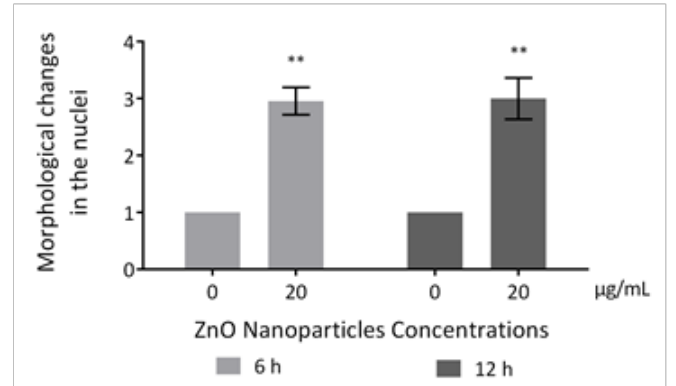
Figure 6. Influence of ZnO NPs in cytoskeleton structure and in nuclear morphology of GC-1 spg cells by immunocytochemistry: Immunocytochemistry images of ( A ) β -tubulin, ( B ) acetylated α -tubulin, and ( A , B ) F-actin; ( C ) relative fluorescence intensity quantification of α -tubulin, β -tubulin, and F-actin protein levels; and ( D ) morphological analysis of nuclei in GC-1 spg cell line. The cells were exposed to 0 and 20 µ g/mL ZnO NPs for 6 h and 12 h. The protein levels are presented as a fold change (%) over controls, which was plotted as mean ± SEM of three independent experiments. Each experiment